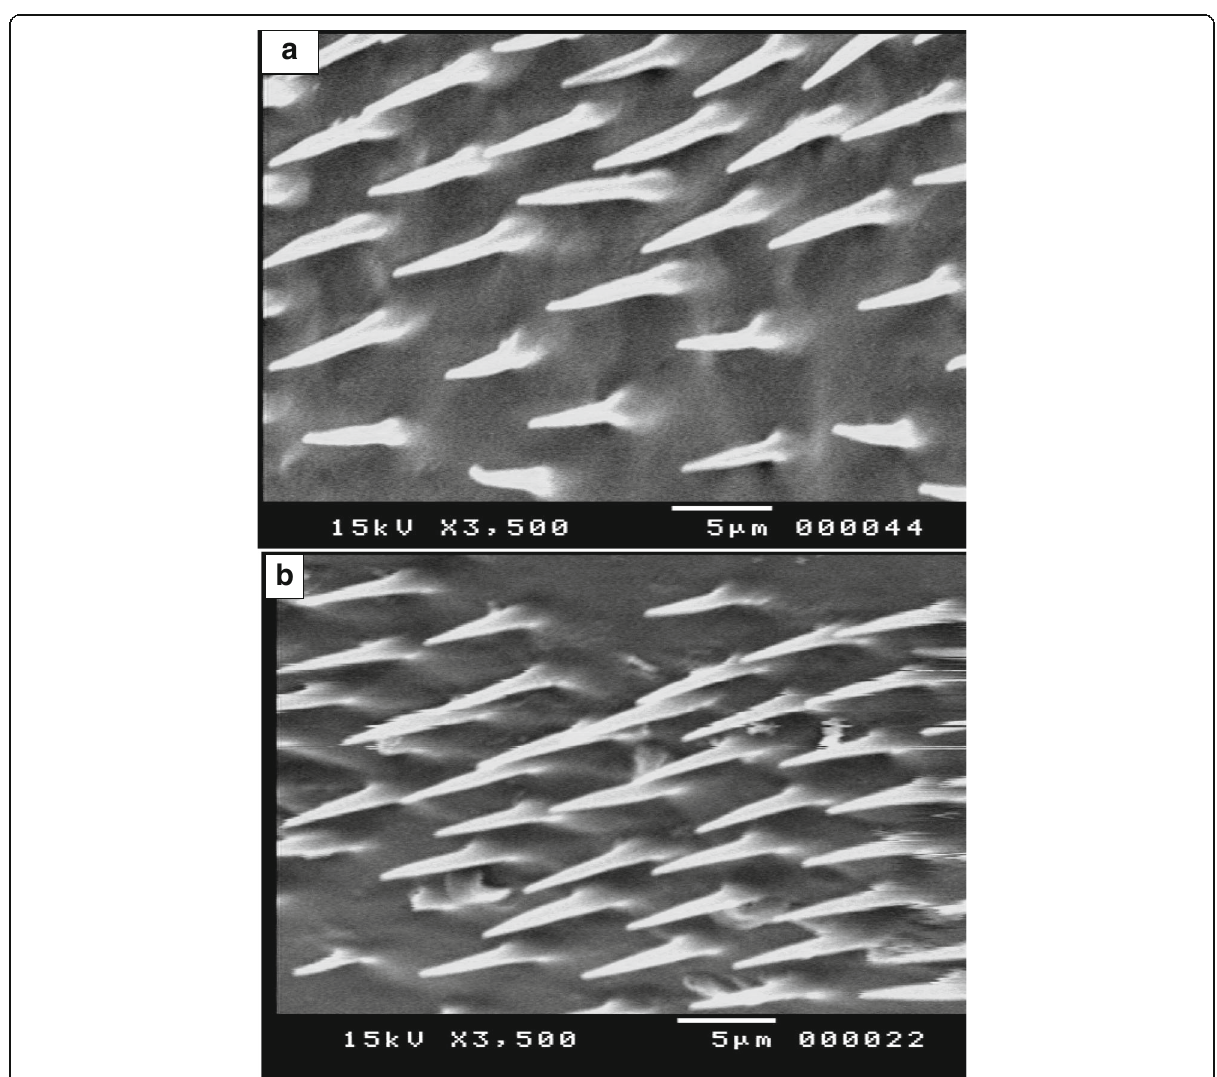
Fig. 4 Scanning electron microscope (SEM) images of spines on the ventral surface of elytron of Tribolium castanaeum ( a ) and Tribolium confusum ( b